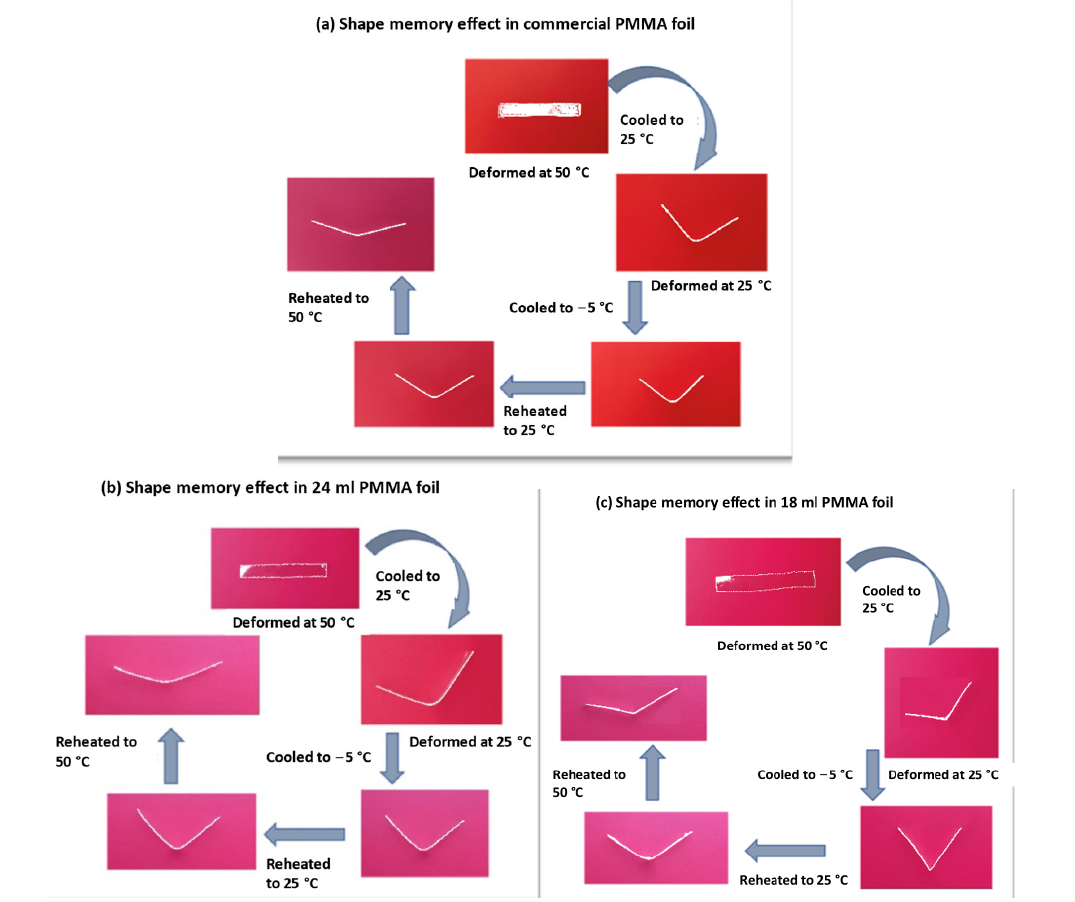
Figure 7. ( a – c ) Shape memory effect of PMMA commercial foil and prepared as ‐ cast foils from 24 Figure 8. ( a – c ) Shape memory effect of PMMA commercial foil and prepared as-cast foils from 24 and 18 mL. and 18